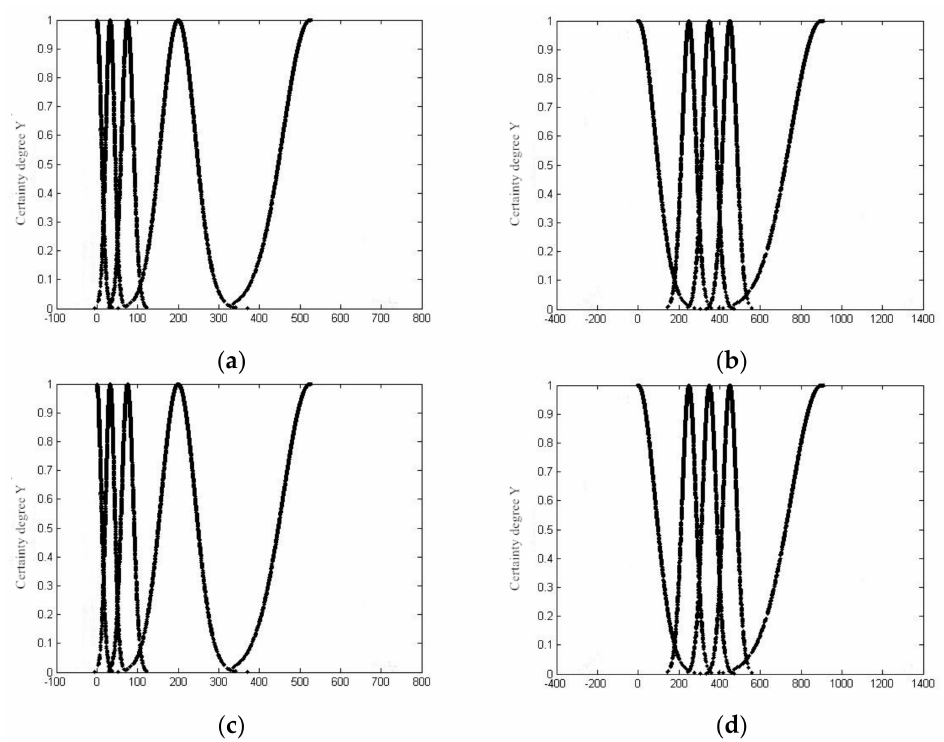
Figure 2. The risk assessment results of water resources and energy security based on the cloud model for ( a ) water consumption per 10,000-yuan GDP (on X-axis); ( b ) water consumption per capita (on X-axis); ( c ) Precipitation (on X- axis);precipitation; ( d ) precipitation coefficient (on